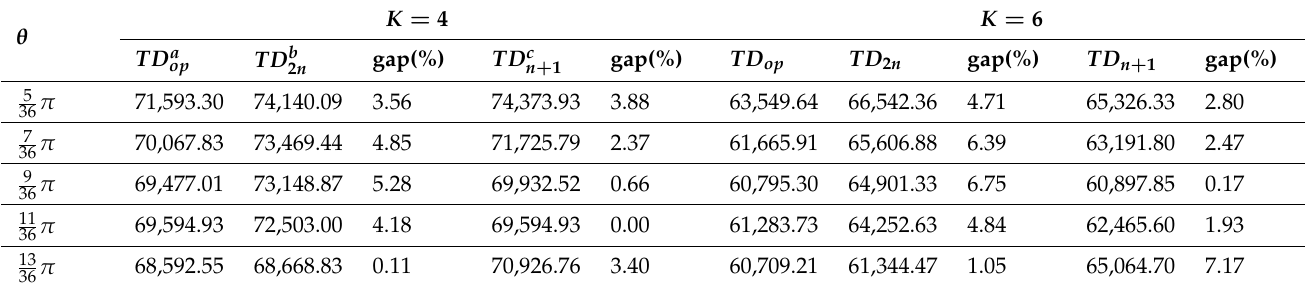
Table 10. Evaluation of two rules for a flying-V layout with varying angles and even workstation